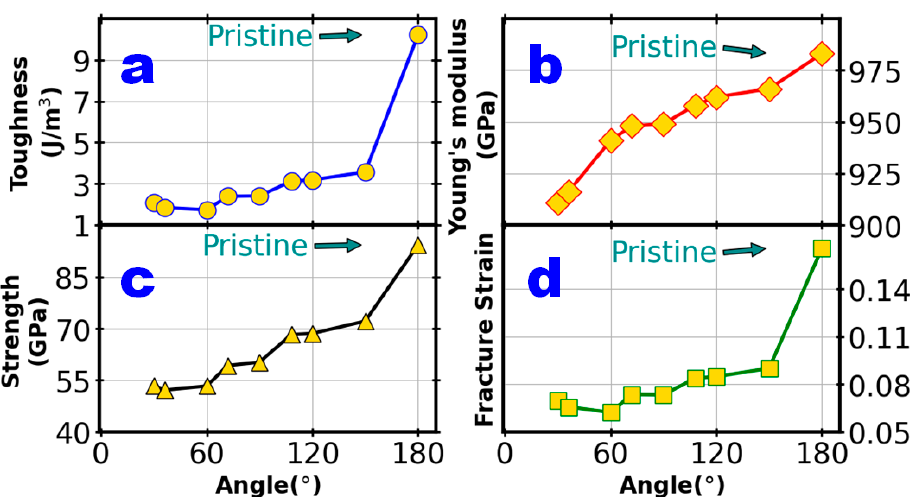
Figure 3. The crack angle shape dependence of cracked SLGSs’ mechanical properties: ( a ) toughness, ( b ) Young’s modulus, ( c ) fracture strength, and ( d ) fracture strain. The tensile simulations were carried out under the following conditions: The temperature was 300 K. The pressure was 0.0001 GPa (1 atm). The strain rate was 10 9 s − 1 . The model I loading was applied along the x axis (armchair direction). The eight SLGSs were pre-cracked in the shape of an isosceles triangle with different vertex angles ranging from 30° to 150° compared with that of pristine graphene.